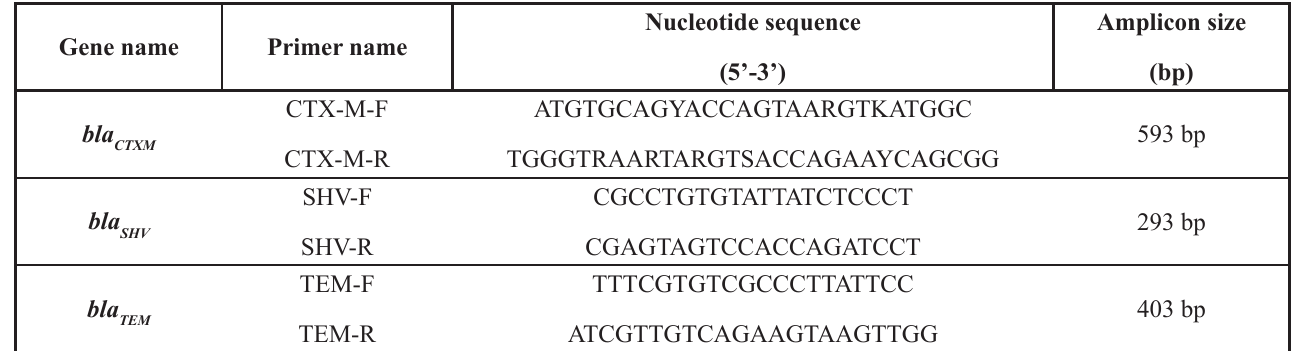
Table 1 . Specific PCR primers for detection of SHV , TEM and CTX-M